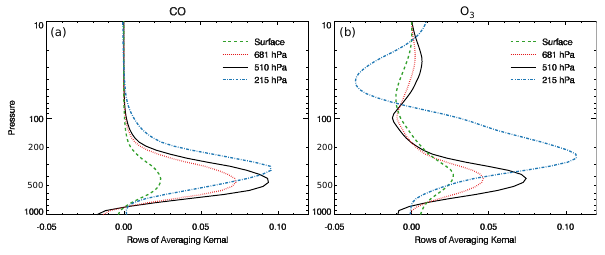
Fig. 1. Averaging kernels of (a) CO and (b) ozone at four differ- ent pressure levels. Data is from TES run 7706 on 3 July 2008 at 44.5 ◦ N, 158.3 ◦